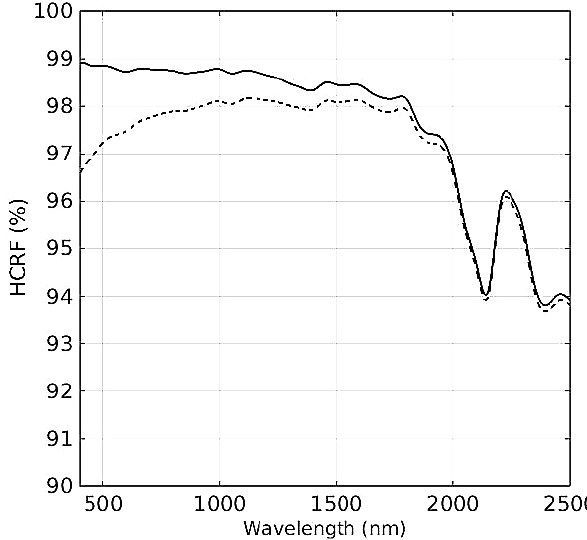
Figure 3. Spectralon ® panel reflectance before (dotted line) and after cleaning (solid line). The panel had been ‘lightly’ and carefully used in the field for one season. Data provided by C. MacLellan, NERC/NCEO Field Spectroscopy Facility, GeoScience, University of